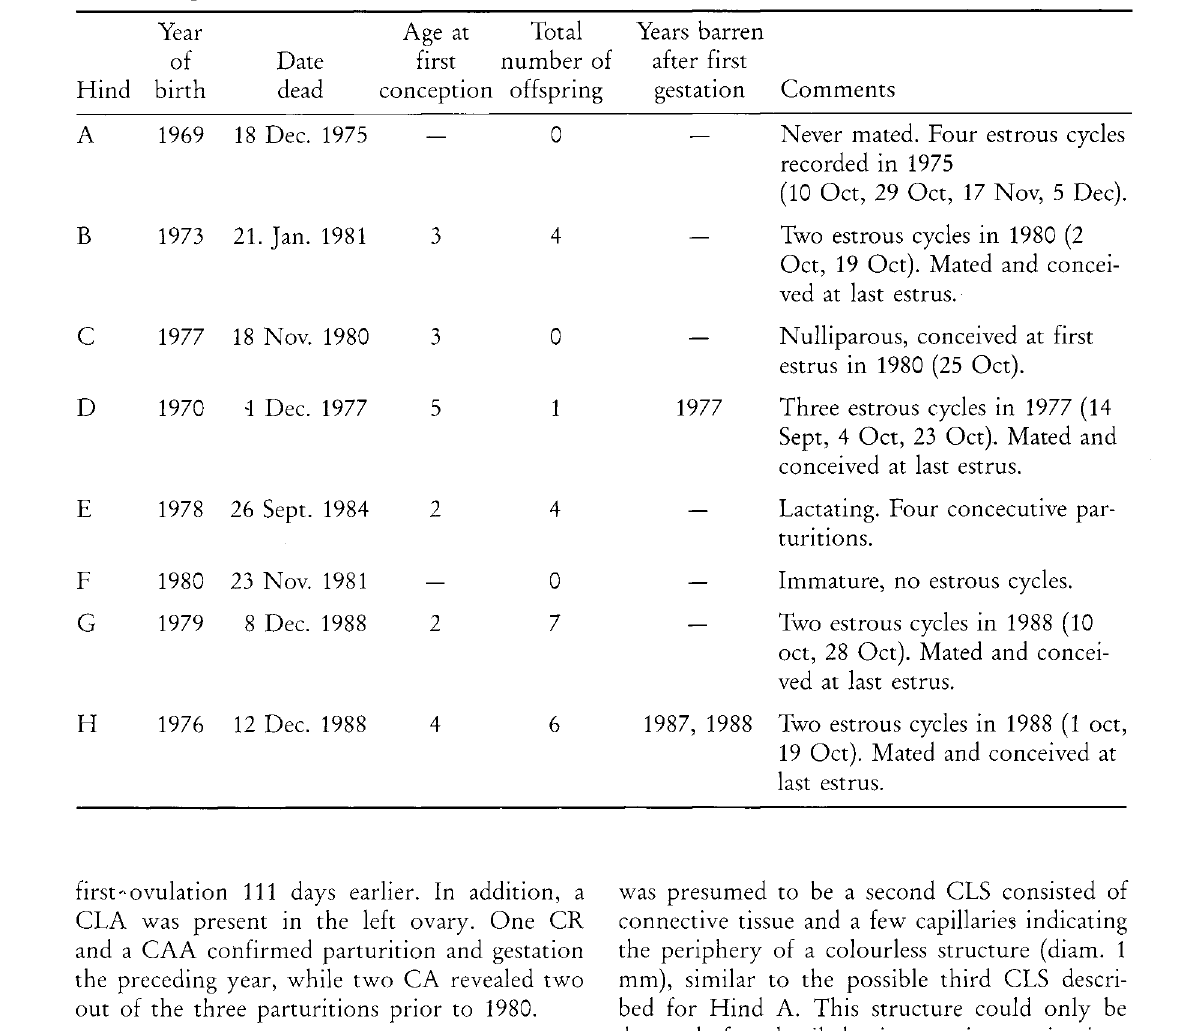
Tab. 5. Structures in the ovaries from 8 hinds